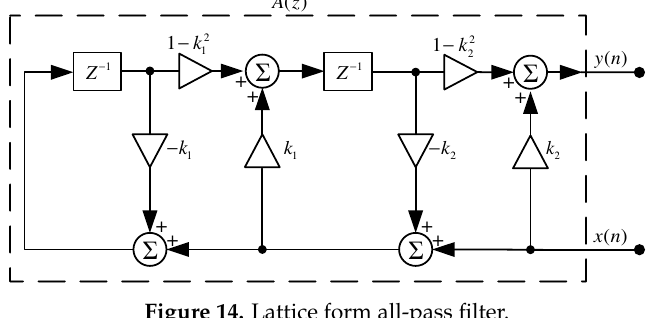
Figure 14. Lattice form all-pass